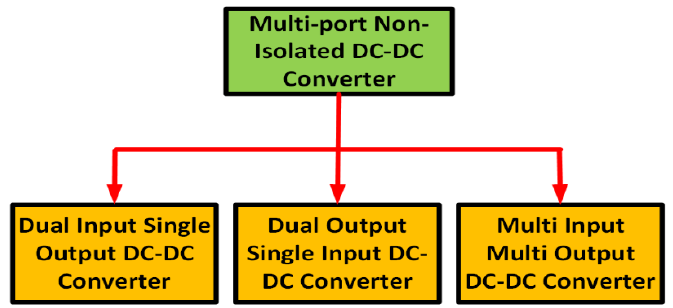
Figure 17. Multiport converter (NI-MPC).